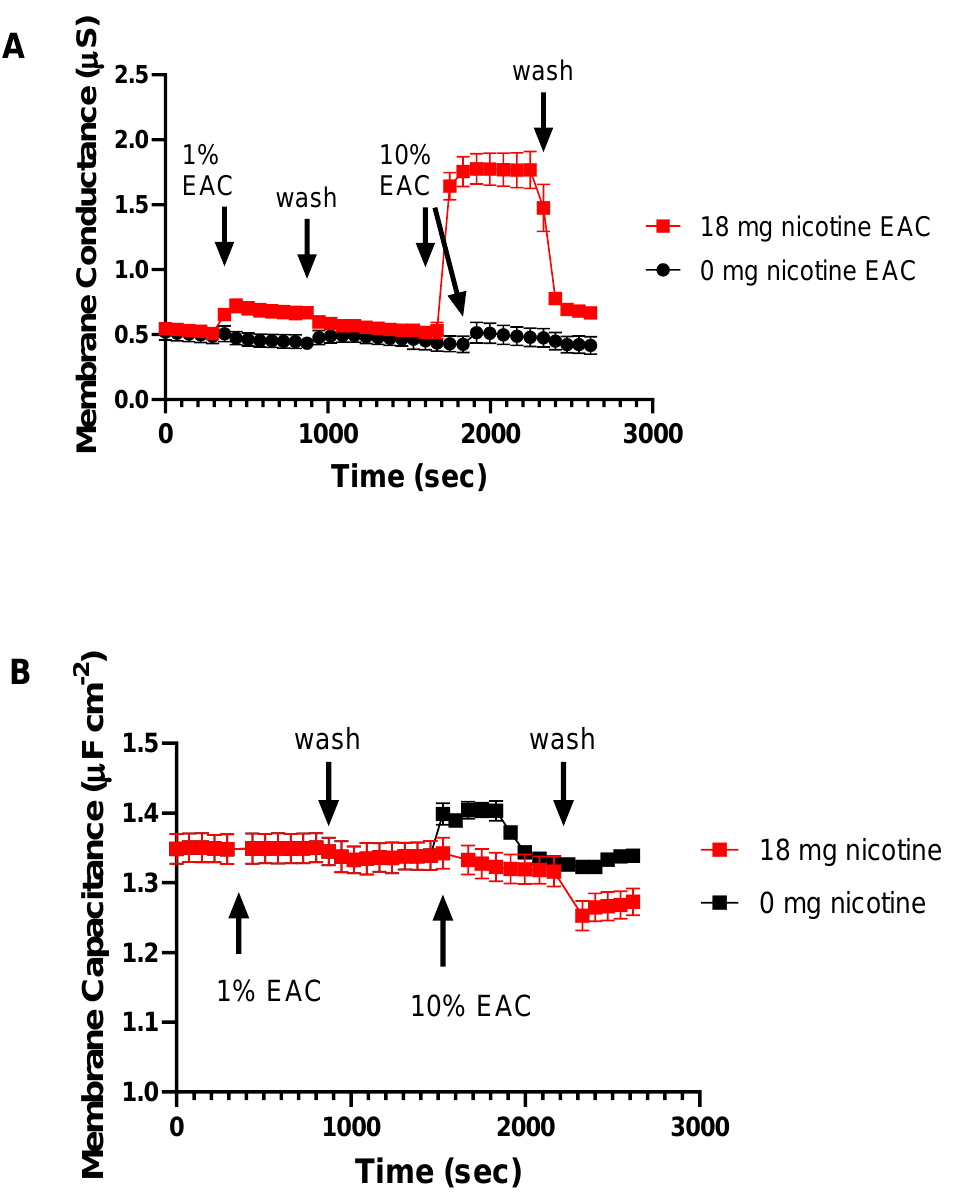
Figure 4. ( A ) Changes in membrane conduction of tethered bilayer lipid membranes (tBLM) in response to EAC (1% and 10%) in 100 mM NaCl 10 mM tris pH 7 buffer (n = 3). EAC solutions containing nicotine increase membrane conduction (membrane permeability). The effect of the nicotine-containing EAC rapidly falls away following a buffer wash. ( B ) In contrast, only minor changes of the membrane capacitances are observed in the same tBLMs, suggesting permeability changes aren’t related to large membrane structural changes.